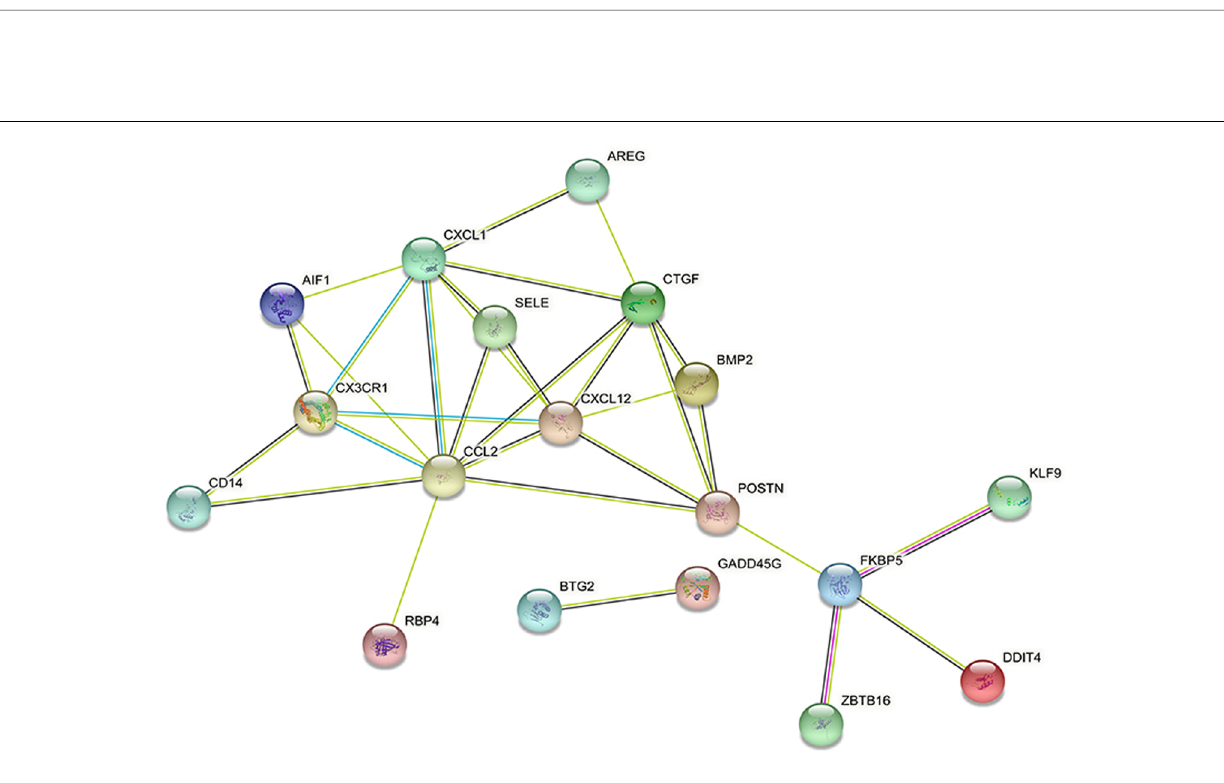
FIGURE 4 Common differentially expressed genes according to the Gene Ontology and Kyoto Encyclopedia of Genes and Genomes databases. ( A ) Biological process of differentially expressed genes. ( B ) Cellular component of differentially expressed genes. ( C ) Molecular function of differentially expressed genes. ( D ) Kyoto Encyclopedia of Genes and Genomes pathway of differentially expressed genes.